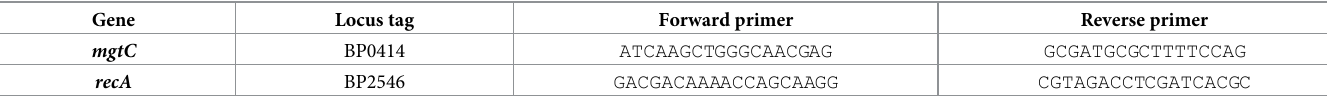
Table 2. Primers used for